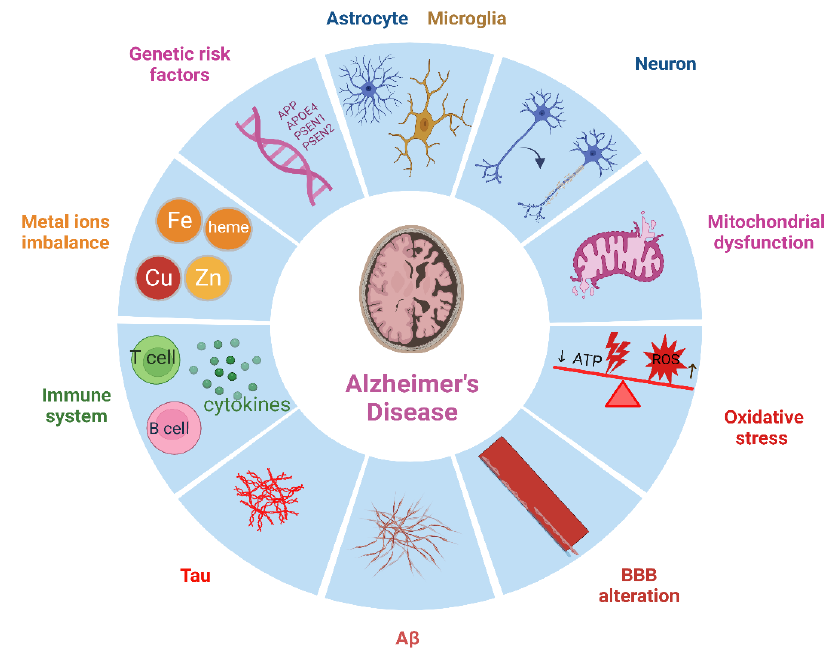
Figure 1. Multiple factors are associated with AD, including defective BBB, mitochondrial dysfunc- tion, oxidative stress, metal ion imbalance, genetic risk factors, and the immune system. Additionally, AD pathogenesis involves T cells, A β , tau, microglia, and astrocytes. A comprehensive understanding of these factors and their interplay is crucial for advancing our understanding of AD and developing effective treatments. Created with BioRender (BioRender.com).